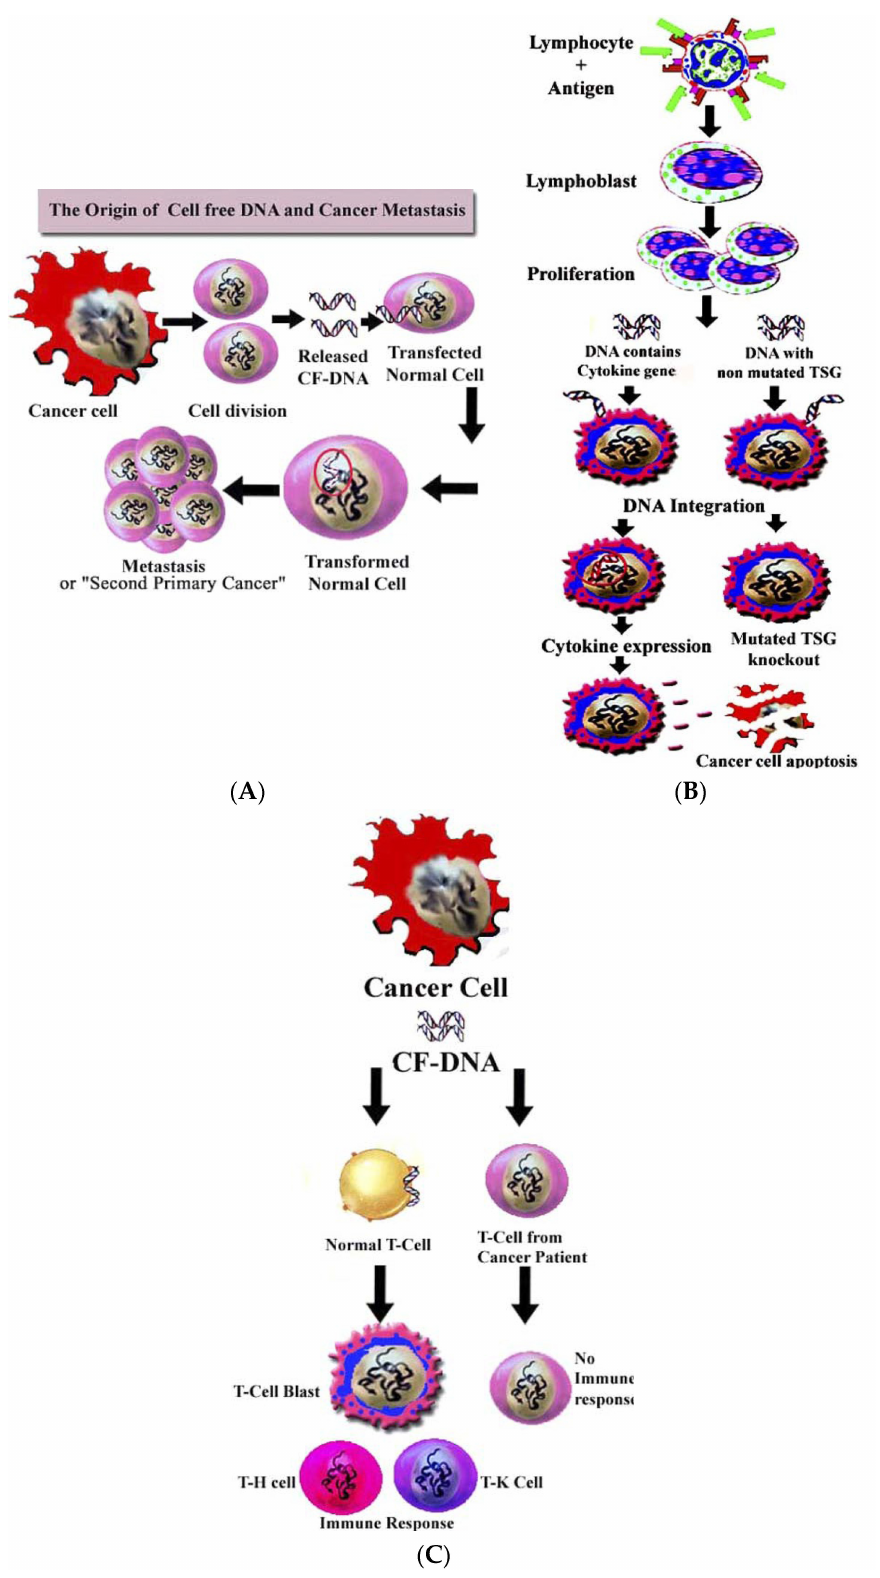
Figure 4. ( A ) The origin of cf-DNA and cancer metastasis. Cancer cells release DNA when they divide. The released DNA (cf-DNA) circulates in the body fluids and has the ability to transfect and transform adjacent or remote normal cells. The transformed cells may keep growing, and so